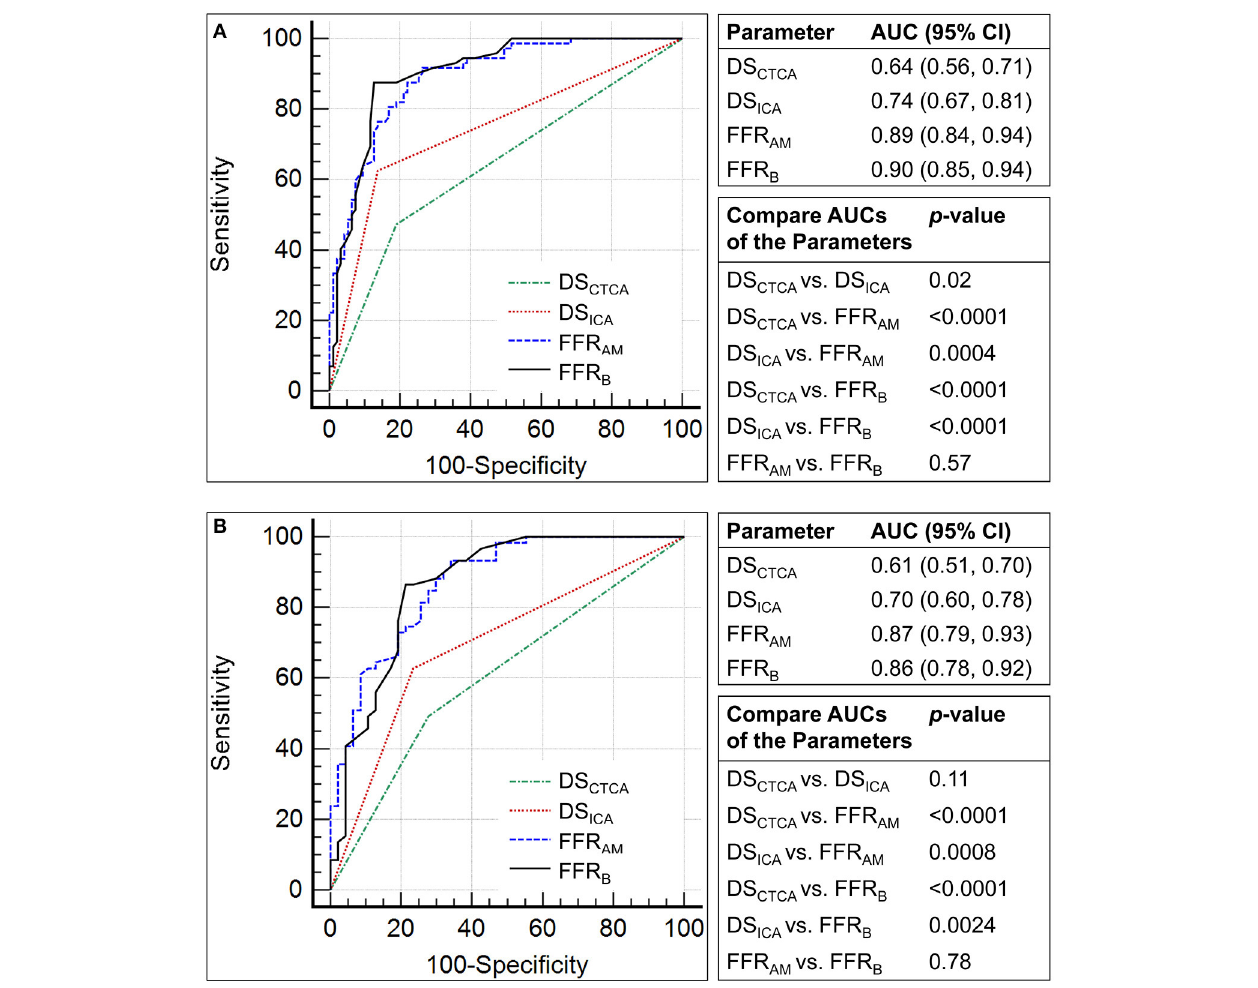
FIGURE 6 | Comparison of the receiver operating characteristic curves for the discrimination of myocardial ischemia (fractional flow reserve, FFR ≤ 0.8) using diameter stenosis (DS; DS CTCA and DS ICA , with a threshold of 70%) and non-invasive FFR (FFR AM and FFR B ) on (A) per-vessel and (B) per-patient